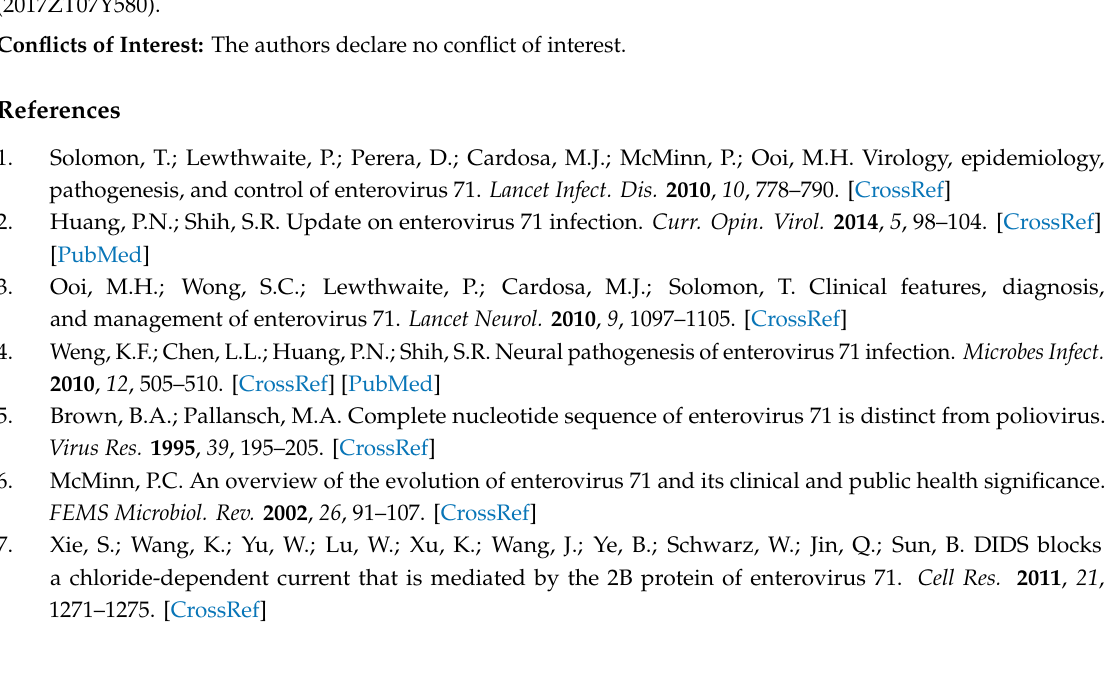
Table S1: The data of microarray analyses of genes di ff erentially expressed in Mock-infected and EV71-infected